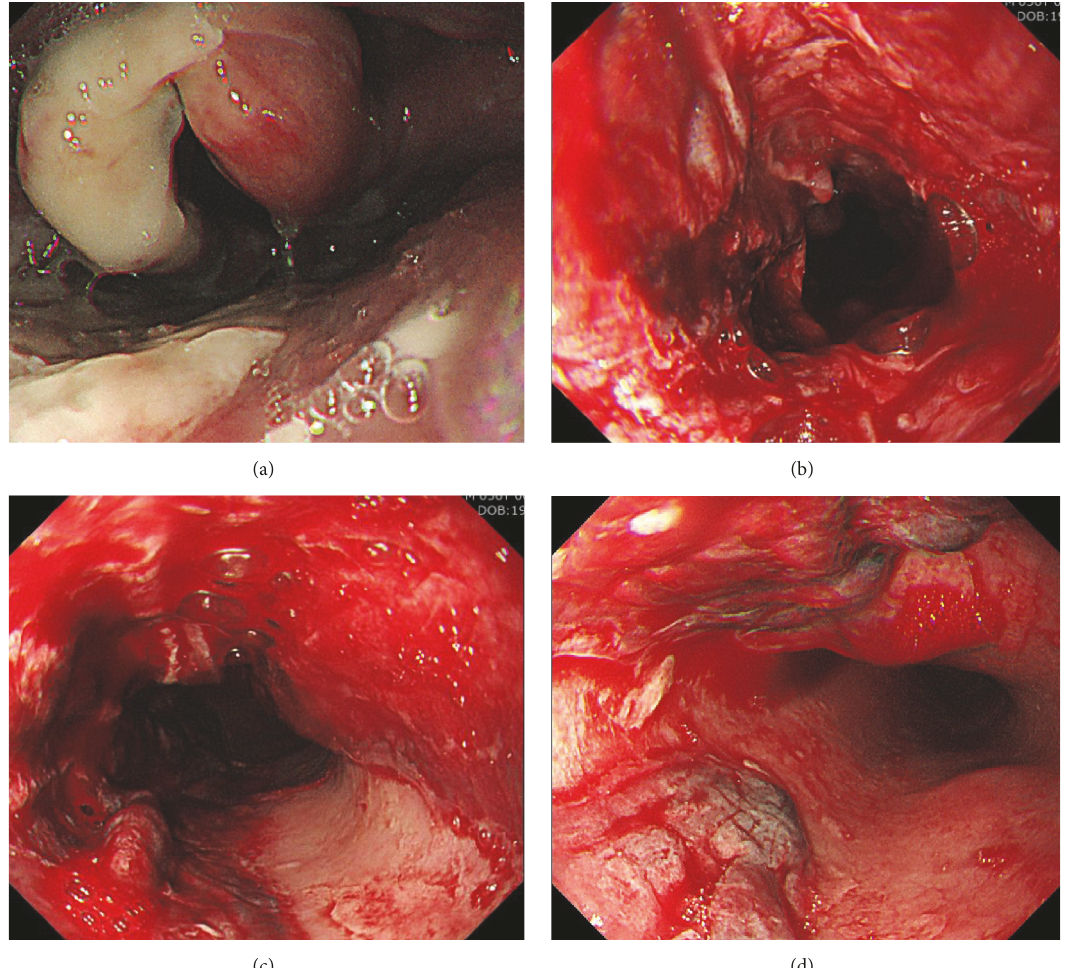
Figure 1: Upper endoscopy at admission. The epiglottis appeared swollen with moderate mucosal injury (a). Diffuse edematous and friable mucosa with deep ulceration and hemorrhage from the upper (b) to mid-esophagus ((c) and (d)).